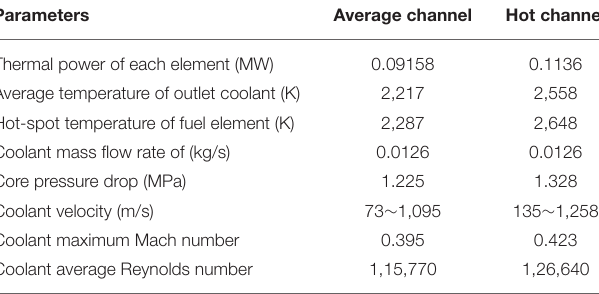
TABLE 5 | Thermal-hydraulic parameters of the reactor